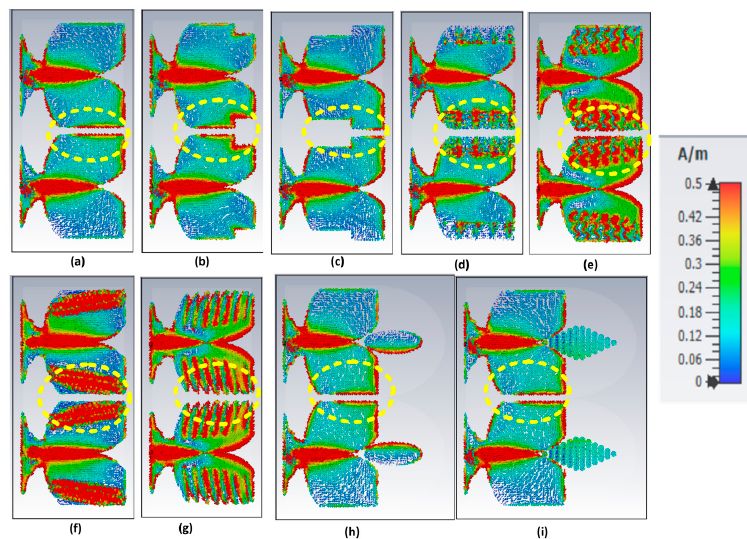
Figure 12. Surface current performance of ( a ) Regular Palm Tree (RPT-CVA), ( b ) Front Cut Palm Tree (FCPT-CVA), ( c ) Back Cut Palm Tree (BCPT-CVA), ( d ) Hilbert Fractal Structure Palm Tree (HFSPT-CVA), ( e ) Vertical Wave Structure Palm Tree (VWSPT-CVA), ( f ) Horizontale Wave Structure Palm Tree (HWSPT-CVA), ( g ) Exponential Slot Edge Palm Tree (ESEPT-CVA), ( h ) Elips Lens Palm Tree (ELPT-CVA), and ( i ) Metamaterial Lens Palm Tree (MLPT-CVA).